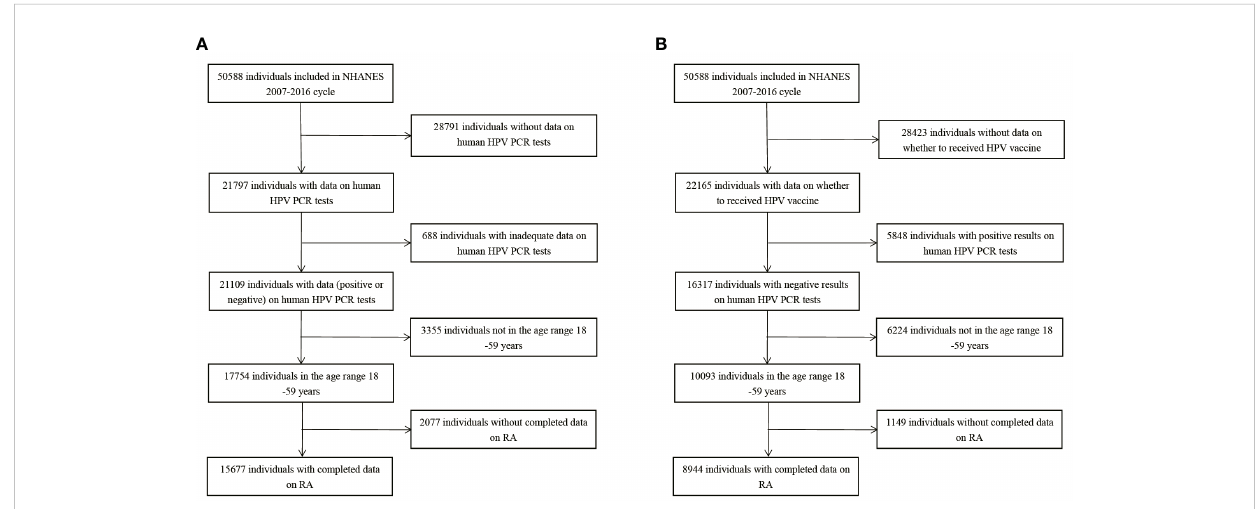
FIGURE 1 Flow chart of population included in our fi nal analysis, NHANES 2007-2016. (A) Flow chart of HPV infection cohort. (B) Flow chart of HPV immunization cohort. HPV, Human papillomavirus; PCR, polymerase chain reaction; RA, rheumatoid